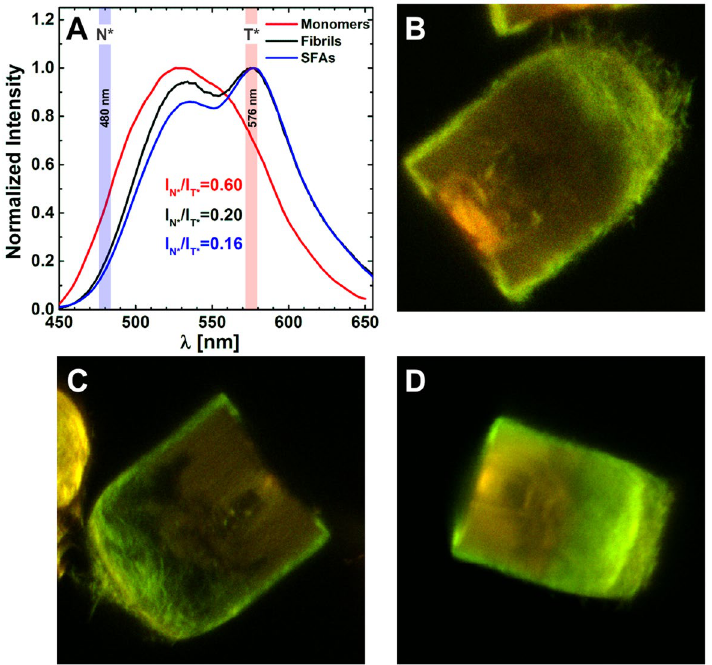
Figure 6. ( A ) Normalized fluorescence emission spectra for aS140C-MFM in monomeric form and in different aggregation states. The environment becomes more polar in the order monomer < fibril < SFAs. Intensities for the N * and T * bands were measured at 480 nm and 576 nm respectively. ( B – D ) CLSM images (red and green overlay) of suprafibrillar aggregates containing 5% α S140C-MFM. The green and red color correspond to emission of the N * and T * forms of the dye recorded at 482 nm (bw 35 nm) and 595 nm (bw 50 nm) respectively. More green color in the image corresponds to regions of more polar environment in the SFAs. The intensity is proportional to the fibril